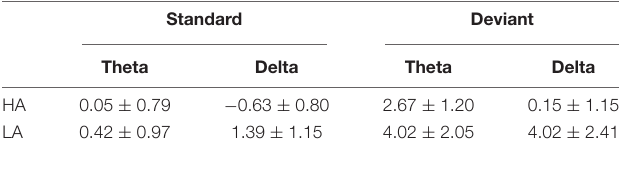
TABLE 4 | Theta and delta band powers for standard and deviant conditions at F3, F4, Fz, FC3, FC4, FCz, C3, C4, and Cz sites in LA and HA groups ( M ± SD ).